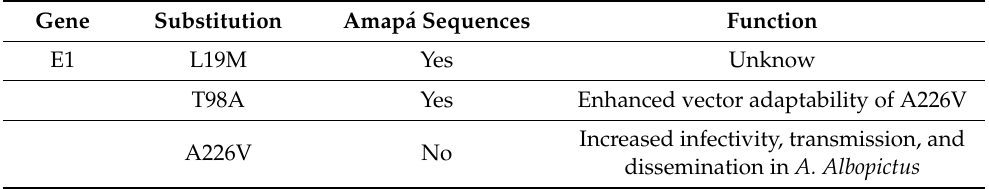
Table 2. Non-synonymous substitutions observed among the 10 CHIKV genomes sequenced in this